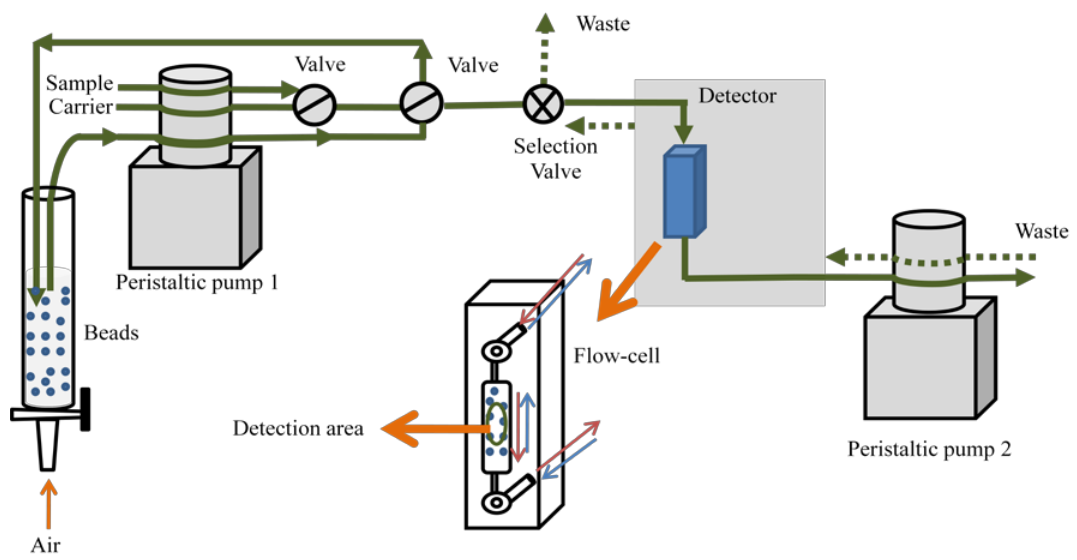
Figure 2. Bead injection